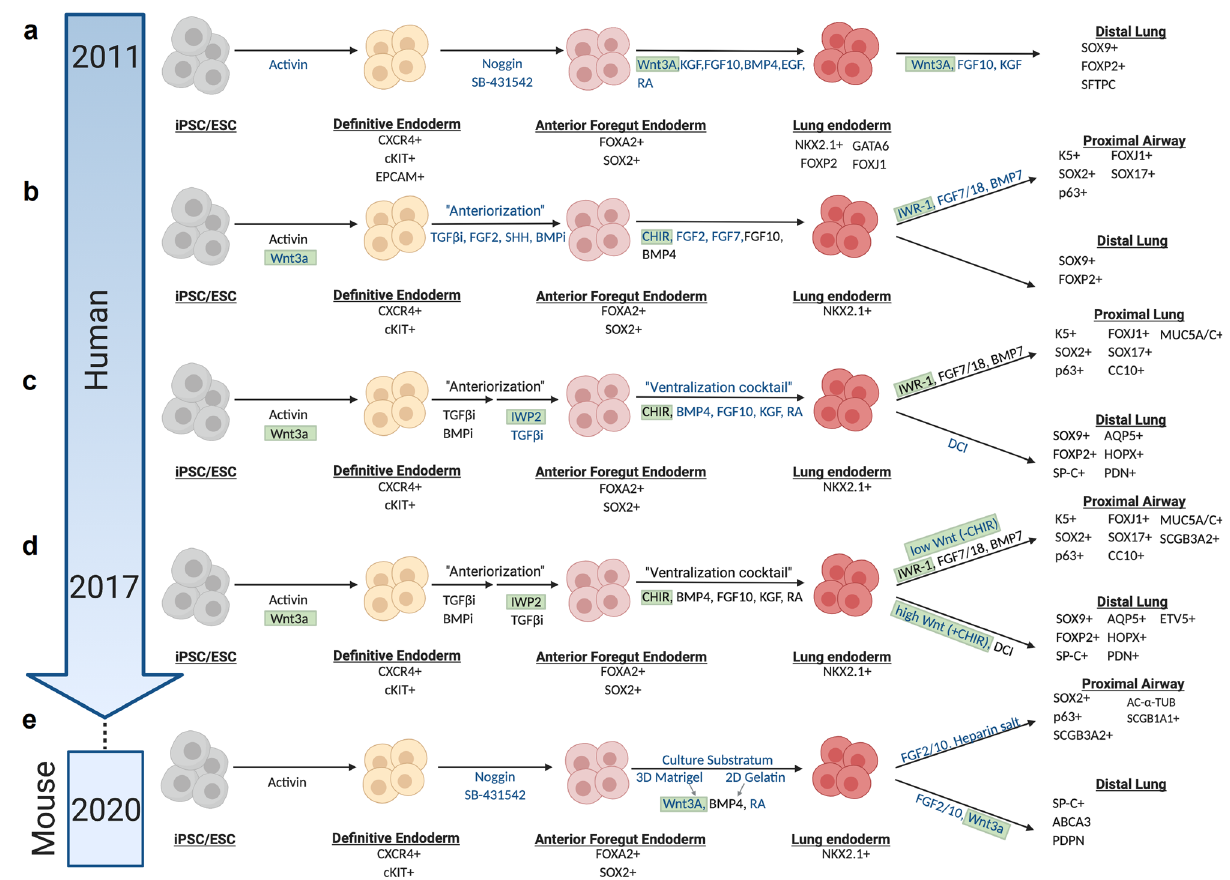
Fig. 4 Directed differentiation of iPSCs to lung lineages utilizes perturbations in Wnt signaling at various stages. a Primary report to lung-directed differentiation utilized Activin to induce de fi nitive endoderm speci fi cation. Use of Noggin and SB431542, a bone morphogenetic protein (BMP) and transforming growth factor beta (TGF β ) family signaling inhibitor, respectively, in Activin A-induced de fi nitive endoderm drives anterior foregut endoderm (AFE) speci fi cation 92 . Further differentiation of the AFE would utilize a WKFBE factor cocktail (WNT3a, keratinocyte growth factor (KGF), fi broblast growth factor (FGF) 10, BMP4, epidermal growth factor (EGF)) alongside retinoic acid (RA) to attain lung endoderm progenitors (NKX2.1 + ) 92 . Consistent with idea that activated Wnt signaling promotes distal lung phenotype, treatment of lung endoderm progenitors with Wnt3a, FGF10, and KGF promotes a distal phenotype 92 . b Subsequent studies introduced Wnt3a, alongside Activin, to generate de fi nitive endoderm. GSK3 β inhibitor CHIR, alongside FGFs and BMPs, facilitates generation of NKX2.1 + lung endoderm from anterior foregut endoderm. Tankyrase inhibition via treatment with IWR-1 skewed cells toward a more proximal fate 95,99 . New additions to differentiation protocols are indicated in blue while Wnt-speci fi c biology is highlighted in green. c Subsequent efforts utilized among other factors in a “ ventralization ” cocktail that allowed for more ef fi cient derivation of NKX2.1 + lung endoderm from anterior foregut endoderm 96 . New additions to differentiation protocols are indicated in blue while Wnt-speci fi c biology is highlighted in green. d Between 2014 – 2017, re fi ned strategies emerged that indicate the importance of the level of Wnt modulation by the absence or addition of CHIR to skew cell fates toward a more proximal or distal fate from NKX2.1 + lung endoderm 98,100,101 . New additions to differentiation protocols are indicated in blue while Wnt- speci fi c biology is highlighted in green. e Most recently, using mouse PSCs, Wnt3a was removed from the generative of de fi nitive endoderm and instead utilized in a “ distalization media ” to skew Nkx2.1 + lung endodermal progenitors to a more distal lung epithelial fate 104 – 106 . New additions to differentiation protocols are indicated in blue while Wnt-speci fi c biology is highlighted in